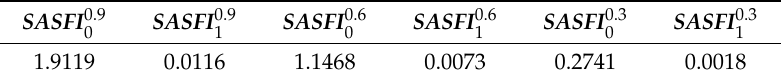
Table 5. SASFI for the network under study (occ. / year).